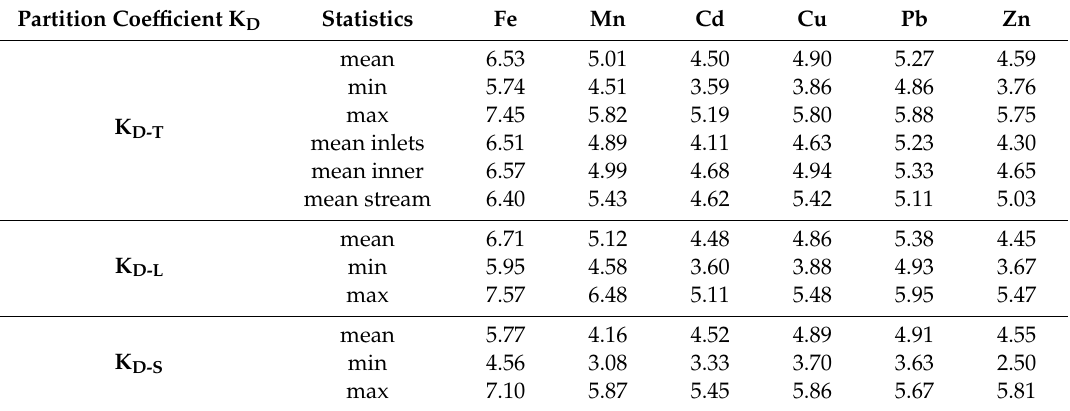
Table 3. Partition coe ffi cient (log 10 ) K D-T for all the particles, K D-L for particles with diameter d > 8 µ m, and K D-S for particles with 0.45 µ m < d < 8 µ